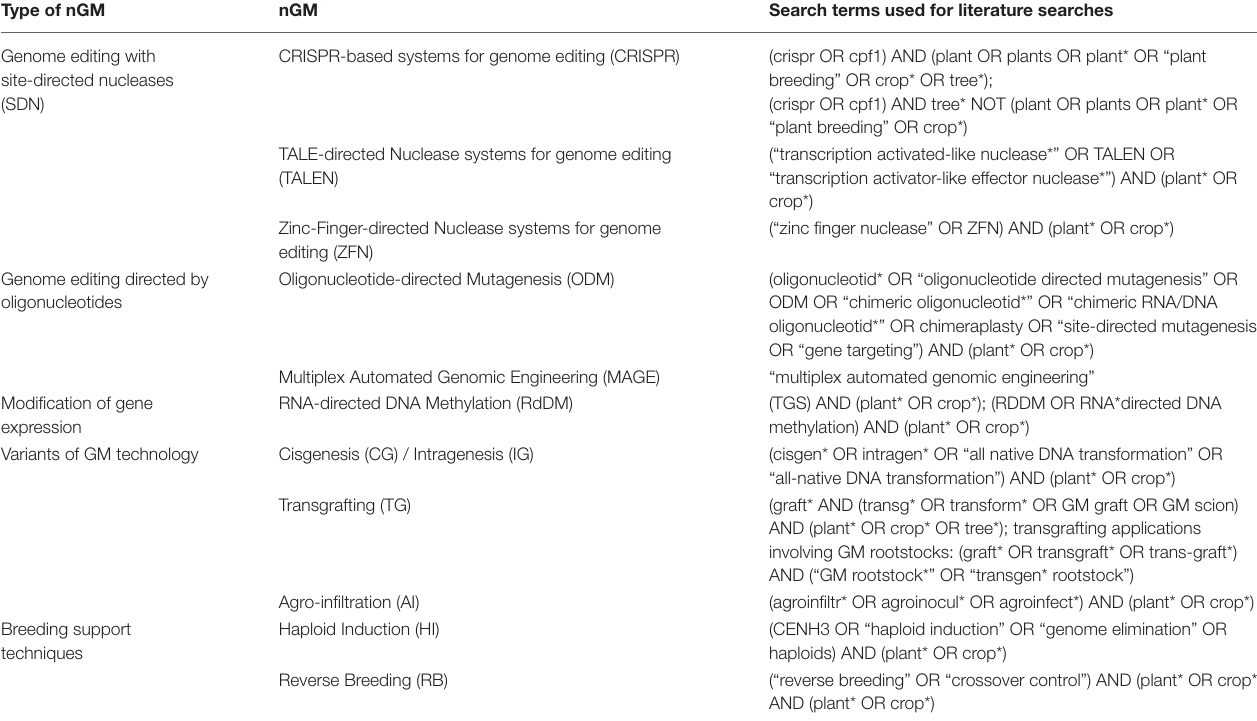
TABLE 1 | Overview of the nGMs addressed in this study and strategy employed for literature search. Type of nGM Search terms used for literature